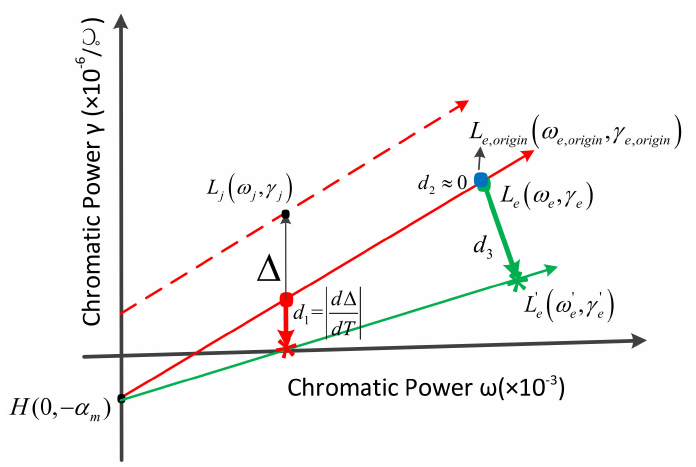
Figure 5. Evaluation method of lens